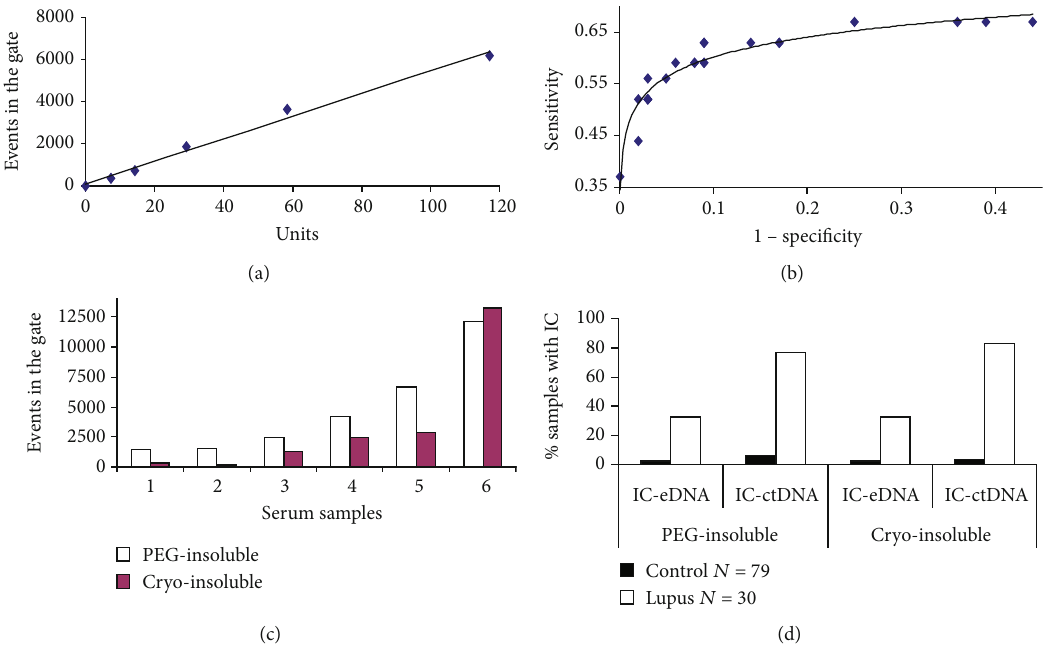
Figure 5: Quantitative measurement and normalization of anti-DNA antibodies and circulating immune complexes detected by fl ow cytometry (FCM). (a) A standard curve for quantitative measurements and normalization of anti-DNA antibodies. A pool of 15 SLE serum samples had been calibrated in international units (IU) against EliA ™ -dsDNA. In each series of tests, a standard 5-point curve was constructed by serial dilution of an aliquot of the pool. Each dilution was incubated with 20 μ g/ml of ctDNA in the same technical conditions than SLE serum samples. In the ordinate events in the gate of IC-DNA and in the abscissa anti-DNA units. (b) The cuto ff for a positive IC result in lupus samples. The cuto ff was determined by a receiver operating characteristic (ROC) curve created by plotting the diagnostic sensitivity against 1 − speci fi city at various threshold settings for lupus sera samples ( N = 30 ) and control sera ( N = 79 ) incubated with ctDNA. The curve shown was observed with the PEG-insoluble immune complexes; a similar curve was observed with the cryo-insoluble immune complexes. (c, d) Comparison of PEG-insoluble to cryo-insoluble immune complexes (IC). (c) Number of events observed in the gates for IC-DNA, by running the cytometer at a fast rate for 1 minute. Serum samples were incubated with 20 μ g/ml ctDNA. 1-3 control serum samples, 4-6 lupus serum samples. The events observed with the control serum samples were due to the background of the FCM test. (d) Percentage of samples with IC above the cuto ff in 30 SLE serum samples with anti-DNA antibodies detected by the routine methods and in 79 control serum samples. Two types of IC are shown: IC with endogenous DNA (eDNA) spontaneously present in SLE serum samples and IC generated after incubation of samples with